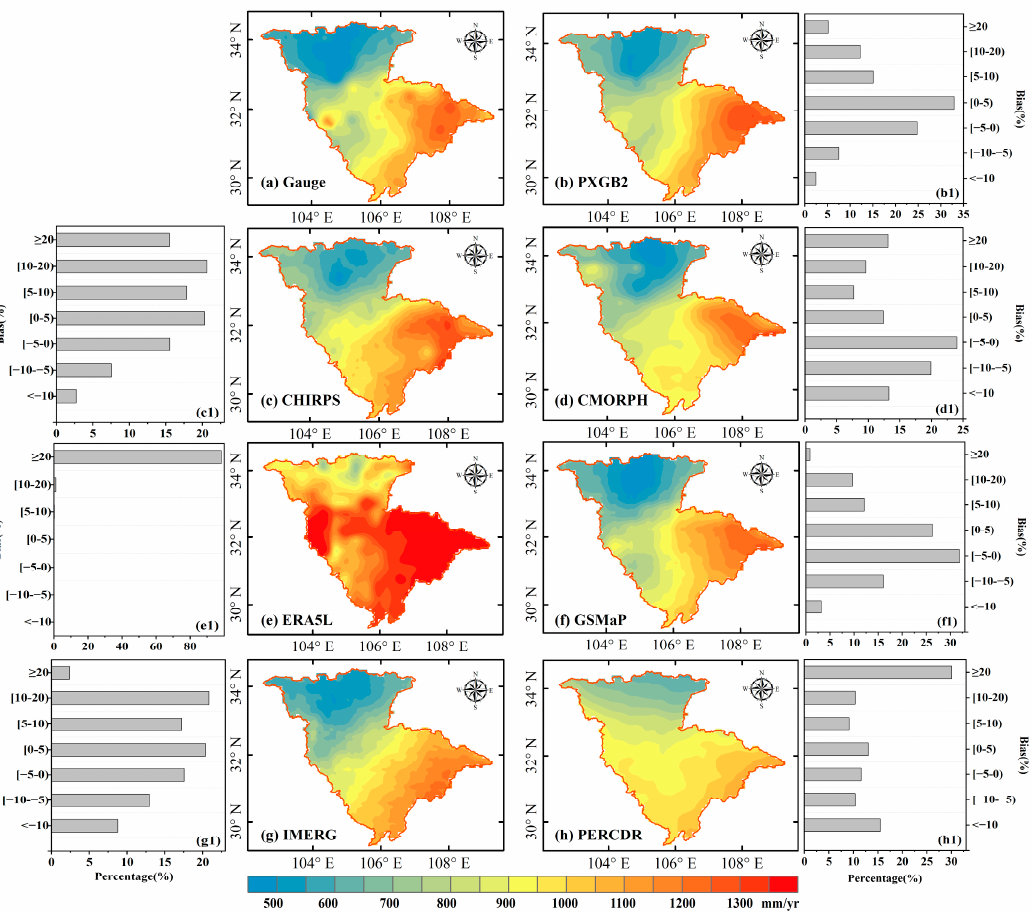
Figure 5. The spatial distribution ( a – h ) of annual precipitation for gauge observations and MSPs, and the bias distribution ( b1 – h1 ) of MSPs. Table 5. The annual precipitation (mm) of gauge observations and MSPs from 2001 to 2006 at the basin